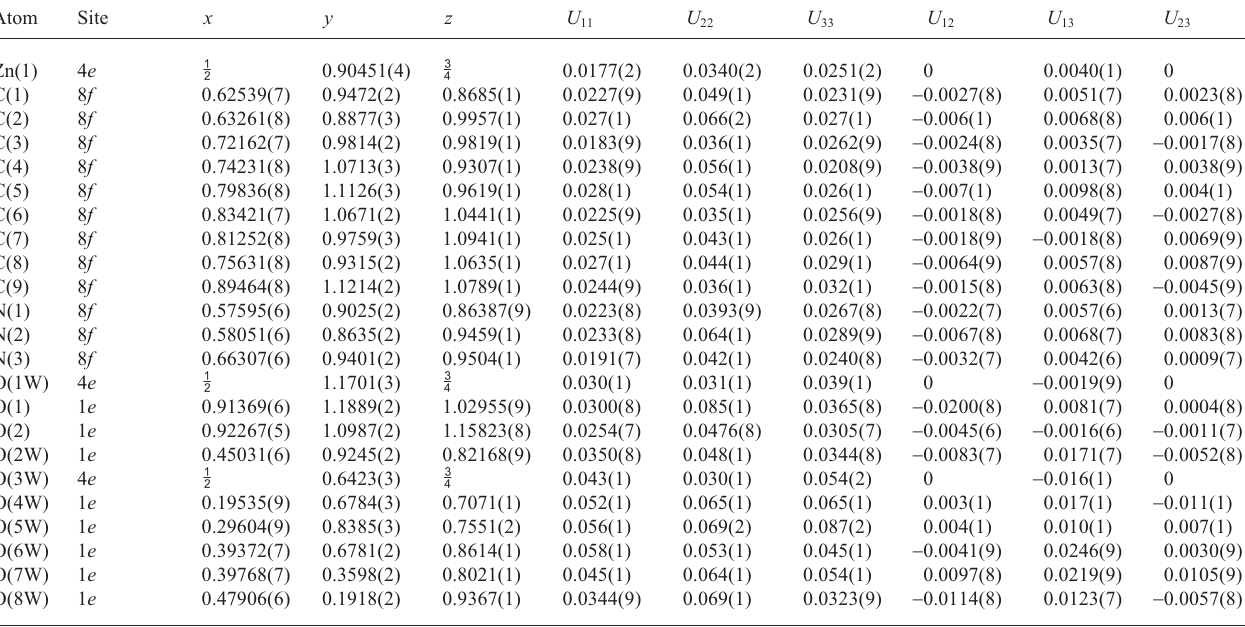
Table 3. Atomic coordinates and displacement parameters (in Å 2 )